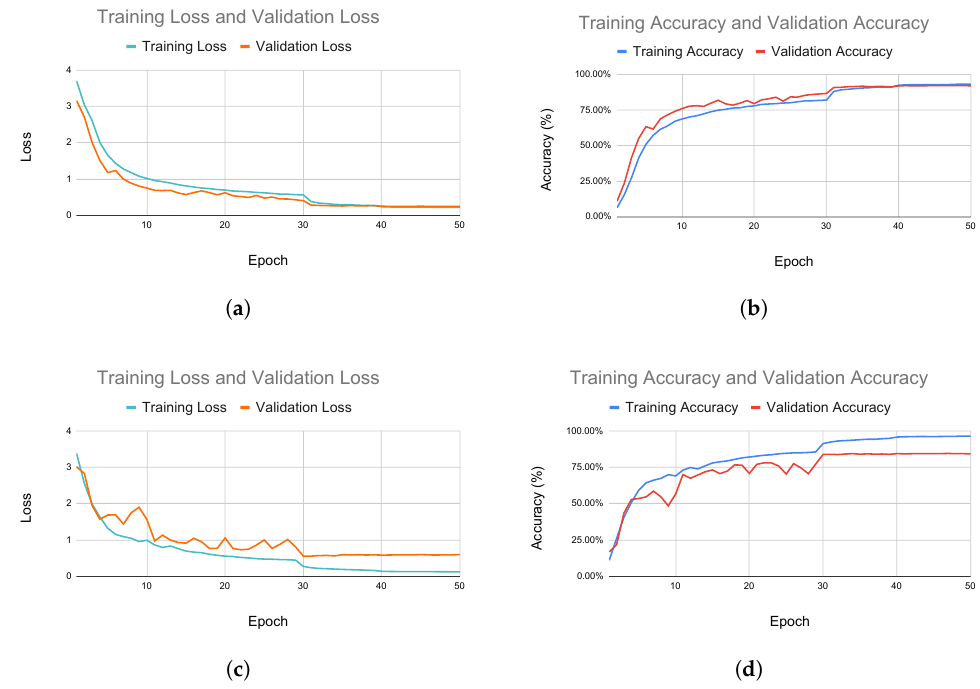
Figure 8. Performance measurement of the training and validation process. ( a ) Comparison between training loss and validation loss for the X-view subset. ( b ) Comparison between training and validation accuracy for X-view subset. ( c ) Comparison between training and validation loss for X-sub subset. ( d ) Comparison between training accuracy and validation accuracy for X-sub subset.